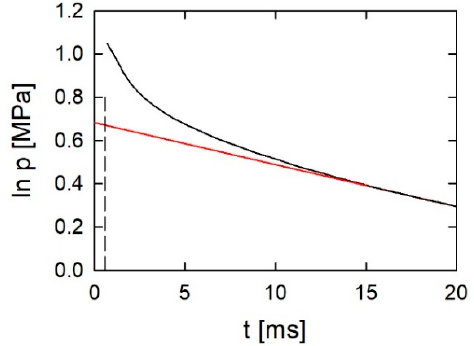
Figure 7. Comparison of ln p and the linear approximation (red line).